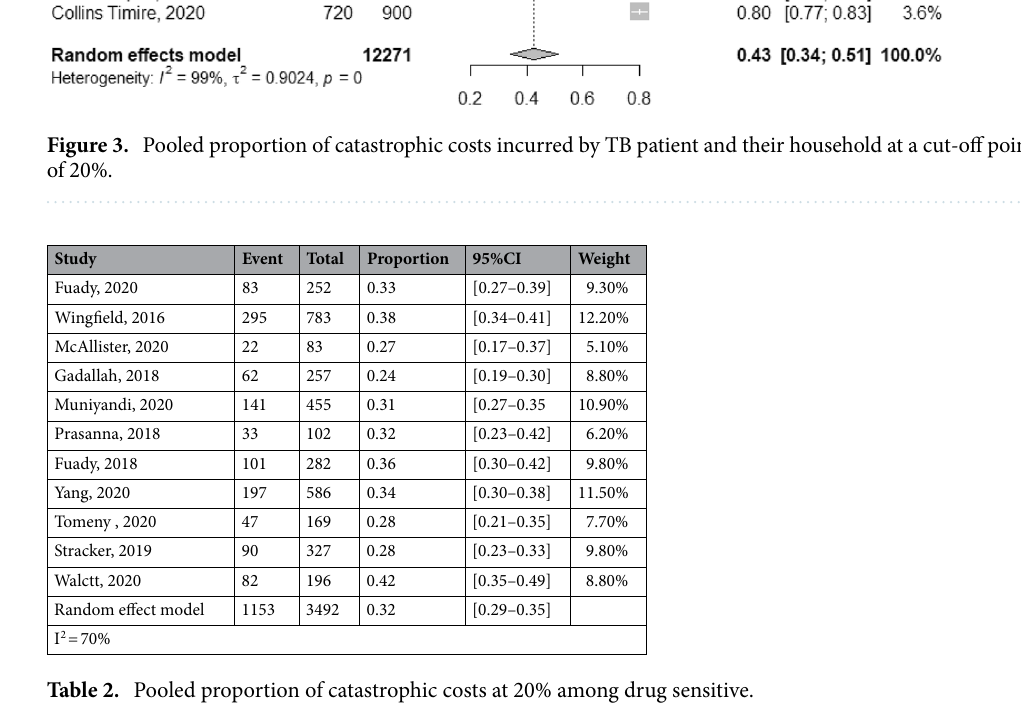
Pooled proportion of catastrophic costs at cut‑off point of 20% among different TB affected patients. Pooled proportion of catastrophic costs at cut‑off point of 20% among TB drug sensitive. The pooled proportion of patients facing catastrophic costs was (39%, 95% CI [28–51]), and the reported heterogeneity was 99%. After removing the outliers 32,36–40,43,45,46 , the pooled proportion of 11 studies that recruited 3492 patients et al. 15 The heterogeneity of the included studies was as follows: I 2 = 70%, p < 0.01 (Table 2).